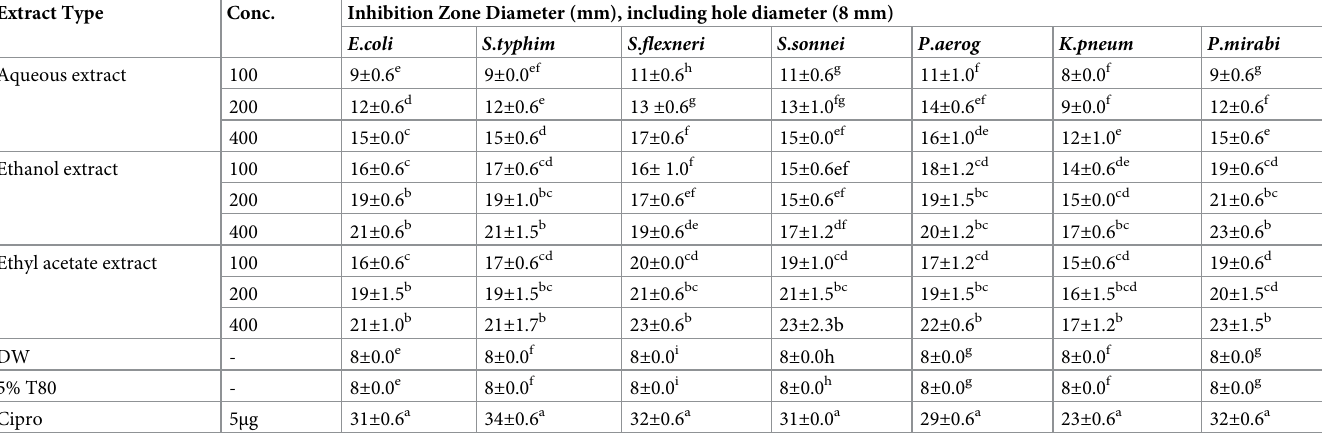
Table 2. Inhibition zone diameter measurement (mm) of crude extracts of I . tinctoria A. Rich roots against gram-negative bacteria. Extract Type